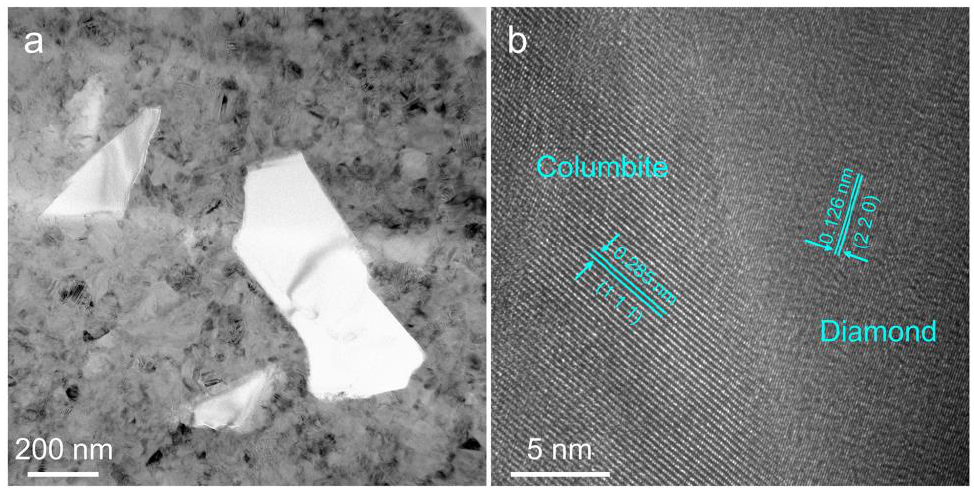
Figure 5. The TEM micrographs showing the interface binding of diamond particles and TiO 2 matrix in the T-10%D sample. ( a ) BF image, ( b ) HRTEM image.